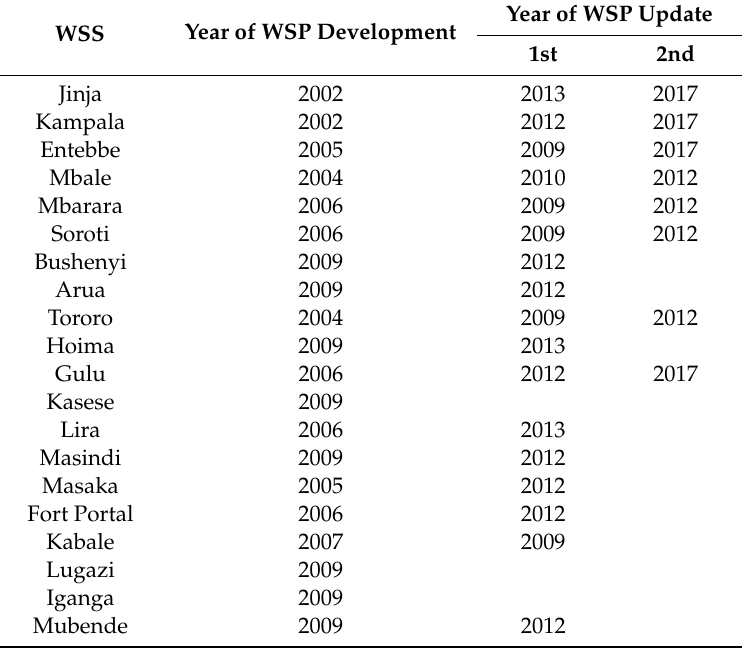
Table 3. Number and years of WSP documentation